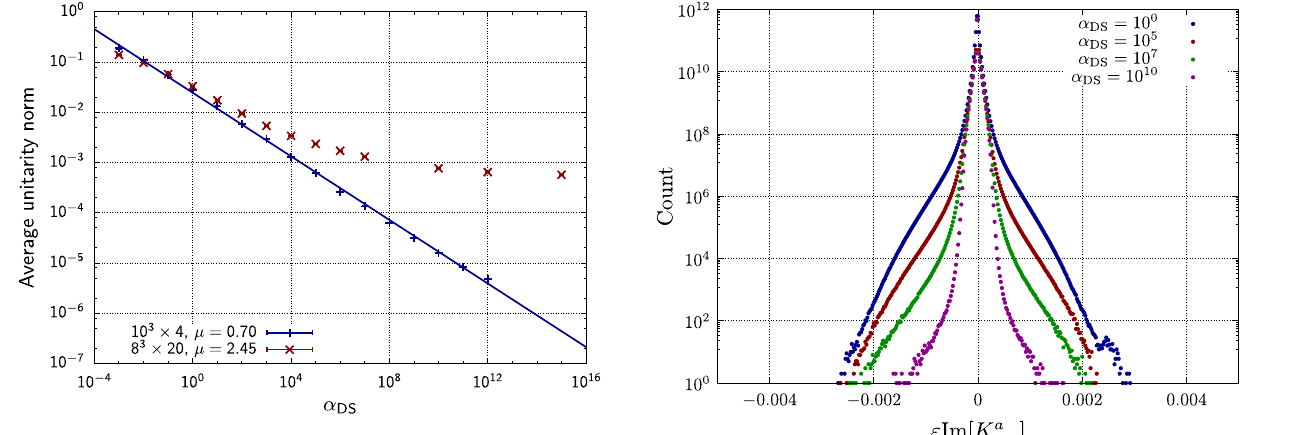
Fig. 6 The average unitarity norm as a function of α DS for HDQCD, with κ = 0 . 04, β = 5 . 8, and volume and chemical potential indicated on the figure. A power-law line was added to the data with average phase close to unity to guide the eye